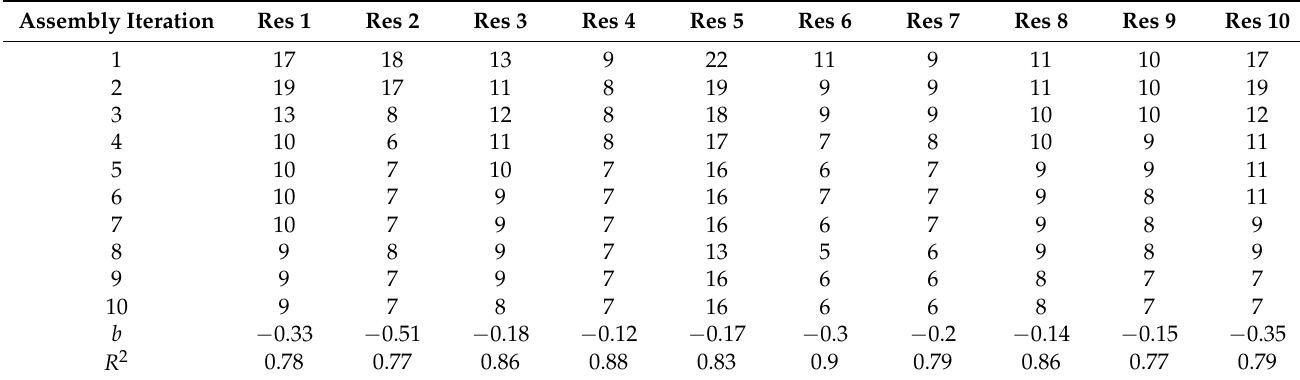
Table 10. Adaptation Ability Data.